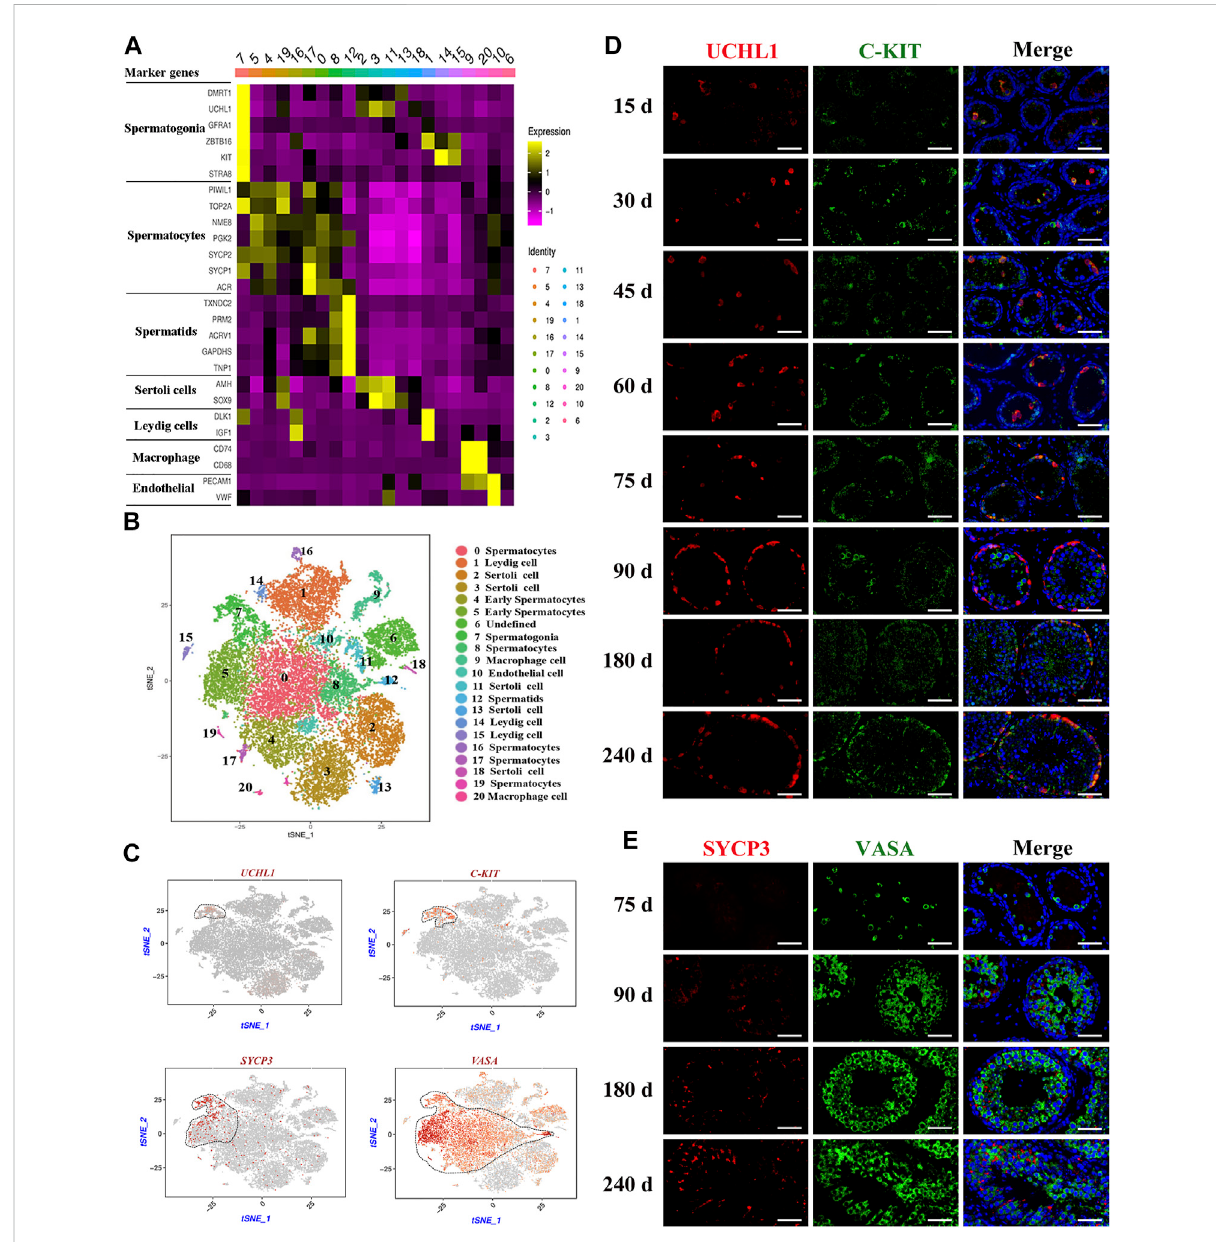
FIGURE 2 Identi fi cation of cell types during spermatogenesis and male germ cells development in dairy goat testes. (A) The marker genes speci fi cally expressed of the cell cluster in heat map. (B) Cell clusters identi fi cation in the tSNE plot. (C) Expression patterns marker genes for male germ cells visualized in t-SNE plots. (D) UCHL1 and C-KIT immunostaining of dairy goat testis sections at each age. Bar = 100 μ M. (E) SYCP3 and VASA immunostaining of dairy goat testis sections at 75 to 240-day-old. Bar = 100 μ M.